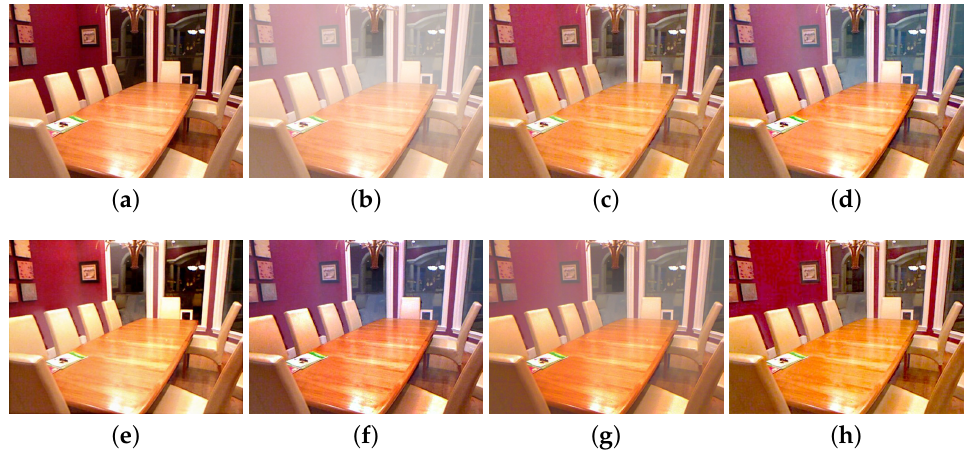
Figure 6. Desk of the SOTS-indoor dataset. ( a ) Ground truth image. ( b ) input blur image. ( c ) DCP;